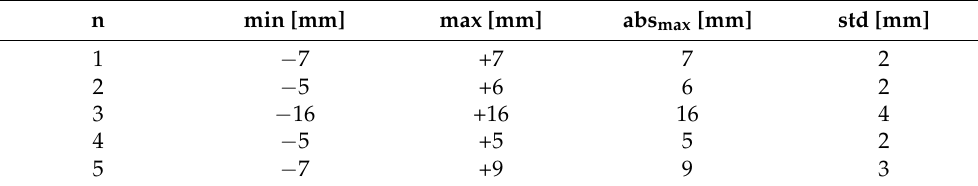
Figure 12. Comparison of the segmented as-built point cloud with the BIM model—column no. 2.: ( a ) plane oriented in the direction of + x -axis, ( b ) plane oriented in the direction of + y -axis, ( c ) plane oriented in the direction of − x -axis, ( d ) plane oriented in the direction of − y -axis. In the case of the selected columns, the absolute maximal distance between the BIM model and the point cloud varies from 4 mm (column no. 1) to 19 mm (column no. 3). The distances between the as-planned and as-built surfaces are within the range − 9 mm (column no. 2) and +14 mm (column no. 3). The positive values mean that the regression plane is in front of the as-planned plane in the direction from the center of the column outwards, the negative values mean opposite direction. The maximal difference between the orientation α of normal vectors is 0.4728 ◦ in the case of the d surface of column no. 3. This angular difference represents a 17 mm deviation at 2 m of the element. The last comparison was carried out in order to quantify the flatness of the surface of the selected inspected elements. The distances of the segmented points were calculated from the corresponding regression planes. Table 3 shows the results for the walls and Table 4 for the columns. Table 3. Inspection of the flatness of the selected walls.